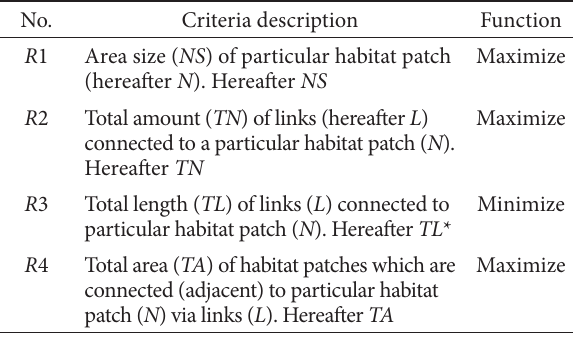
Table 2. Importance of criteria No.